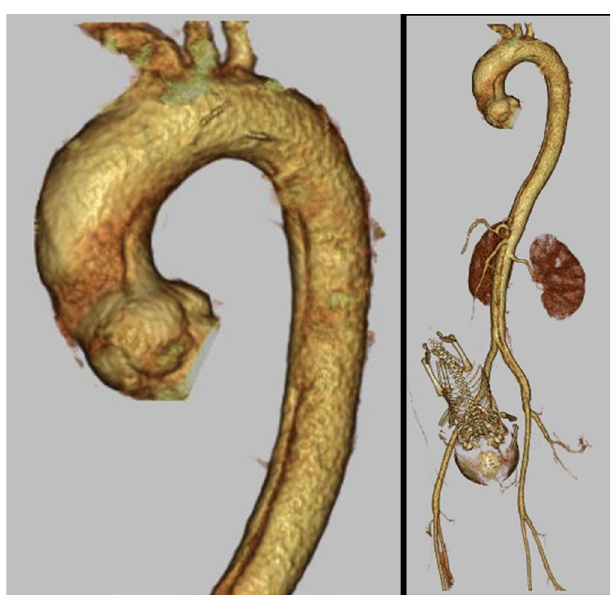
Fig. 1 – Preoperative computed tomography image Acute type A aortic dissection reaches the abdominal aorta, and pregnancy is